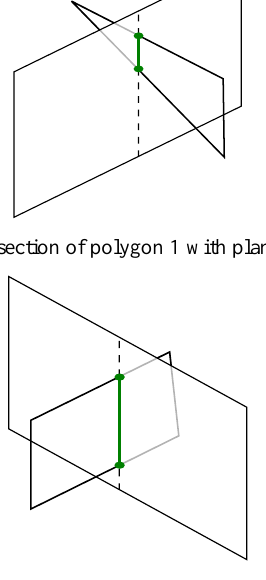
Figure 14: Intersection of polygon 2 with plane of polygon 1